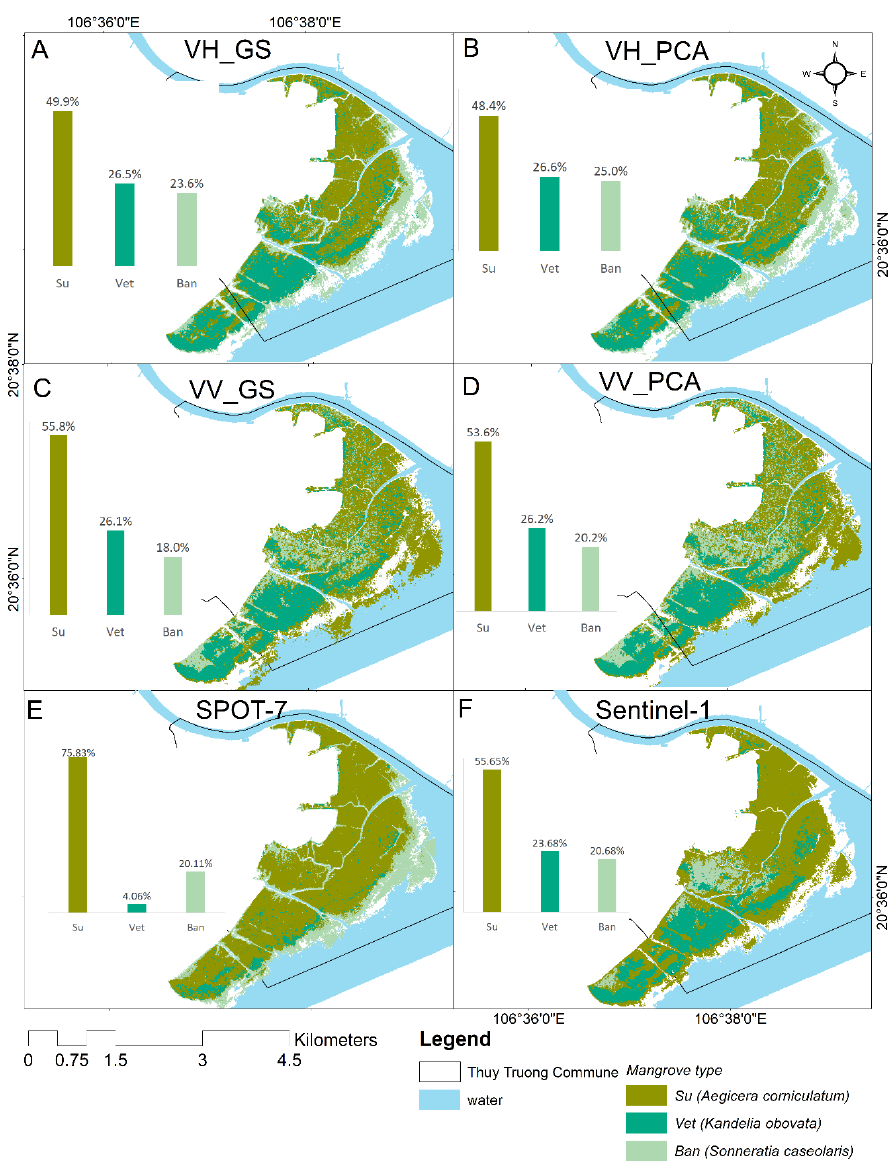
Figure 6. Maps of classified mangrove species; GS and PCA indicate Gram–Schmidt and principal component analysis image fusion methods; V and H are vertical and horizontal, respectively and coupled lettersof VH and VVindicate SAR cross-polarizations. VH_GS, VH_PCA, VV_GS, and VV_PCA are combinations of fused images of SPOT-7 acquired on 17 May 2019 and Sentinel-1 polarization data (VH or VV) and the image fusion methods (GS or